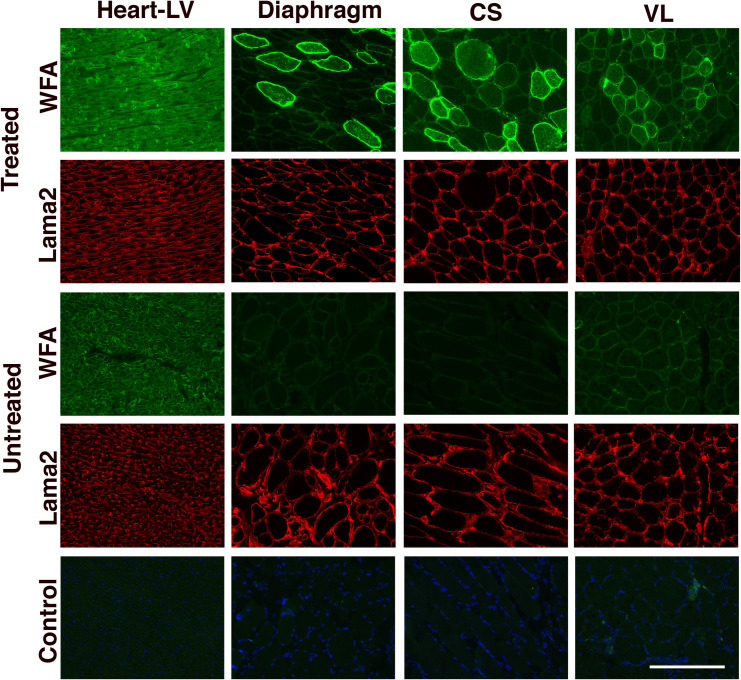
WFA staining after treatment of GRMD dogs with rAAVh74.MHCK7.GALGT2.Muscle sections from 6-month-old GRMD dogs treated (or untreated) at 3 months of age with 2x1014vg/kg of rAAVrh74.MHCK7.GALGT2 were assayed for GALGT2-induced glycosylation. Sections were stained with WFA (green), to identify βGalNAc made by GALGT2, and with antibody to laminin α2 (Lama2, red), to identify sarcolemmal membranes. Control shows merged red, green and blue fluorescence signal without WFA and with only secondary antibody, with DAPI (blue) added as a nuclear co-stain. Sections were stained from heart (left ventricle, LV), diaphragm, cranial sartorius (CS), and vastus lateralis (VL). All exposures are time matched. Bar is 100μm for all panels.